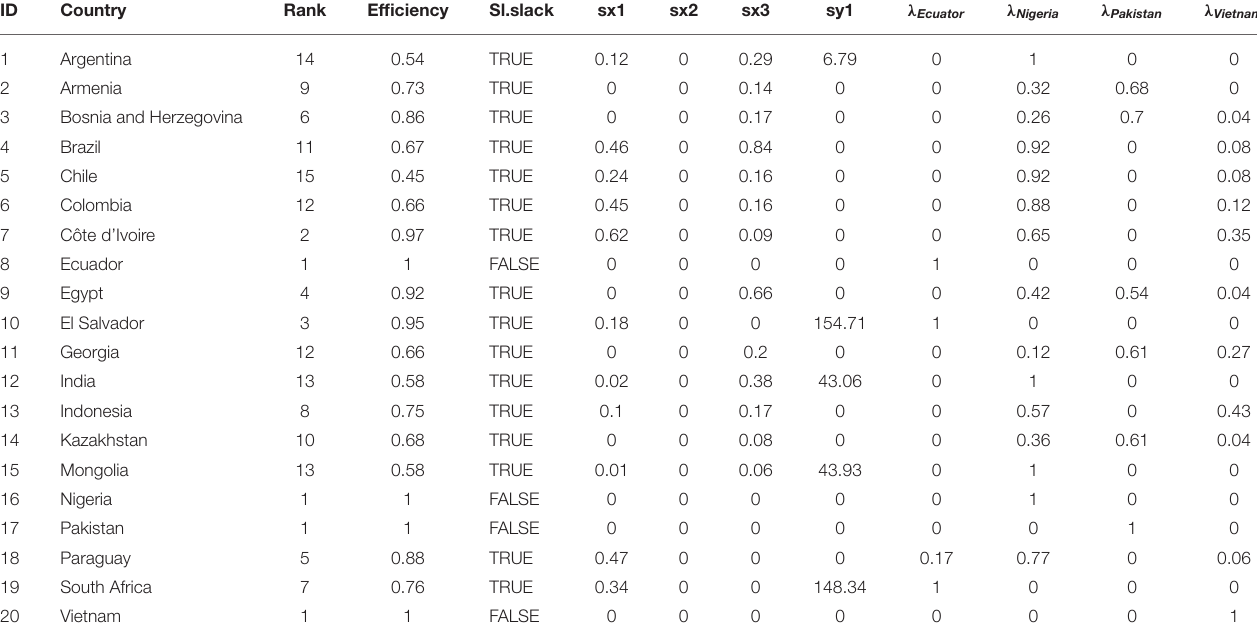
TABLE 4 | Results of the BCC model for Cluster 2 (other developing